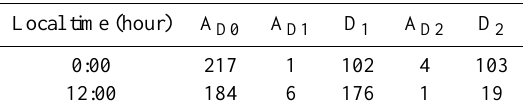
Table 2. The extremum of LTH (maximum values H max , and min- imum values H min ) (km) of daily variation and its corresponding local time (h).